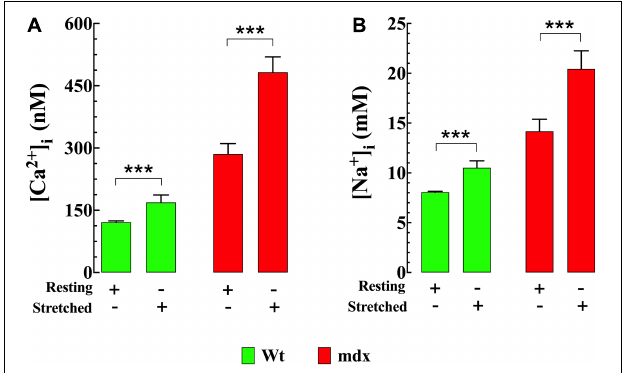
FIGURE 7 | Stretch induces elevation of [Ca 2 + ] i and [Na + ] i in VSMCs. Repetitive mechanical (30 cycles/min) elongation (20% of resting length) produced a significant elevation of [Ca 2 + ] i and [Na + ] i in Wt and mdx VSMc, however, the magnitude of the increase of intracellular Ca 2 + and Na + concentrations was greater in mdx than Wt (A,B) . For [Ca 2 + ] i : n mice = 4/experimental condition, n cell = 20–28/genotype. For [Na + ] i : n mice = 3/experimental condition, n cell = 10–19/genotype. Values are expressed as means ± S.D. for each condition. Student’s t -test, *** p ≤ 0.001.